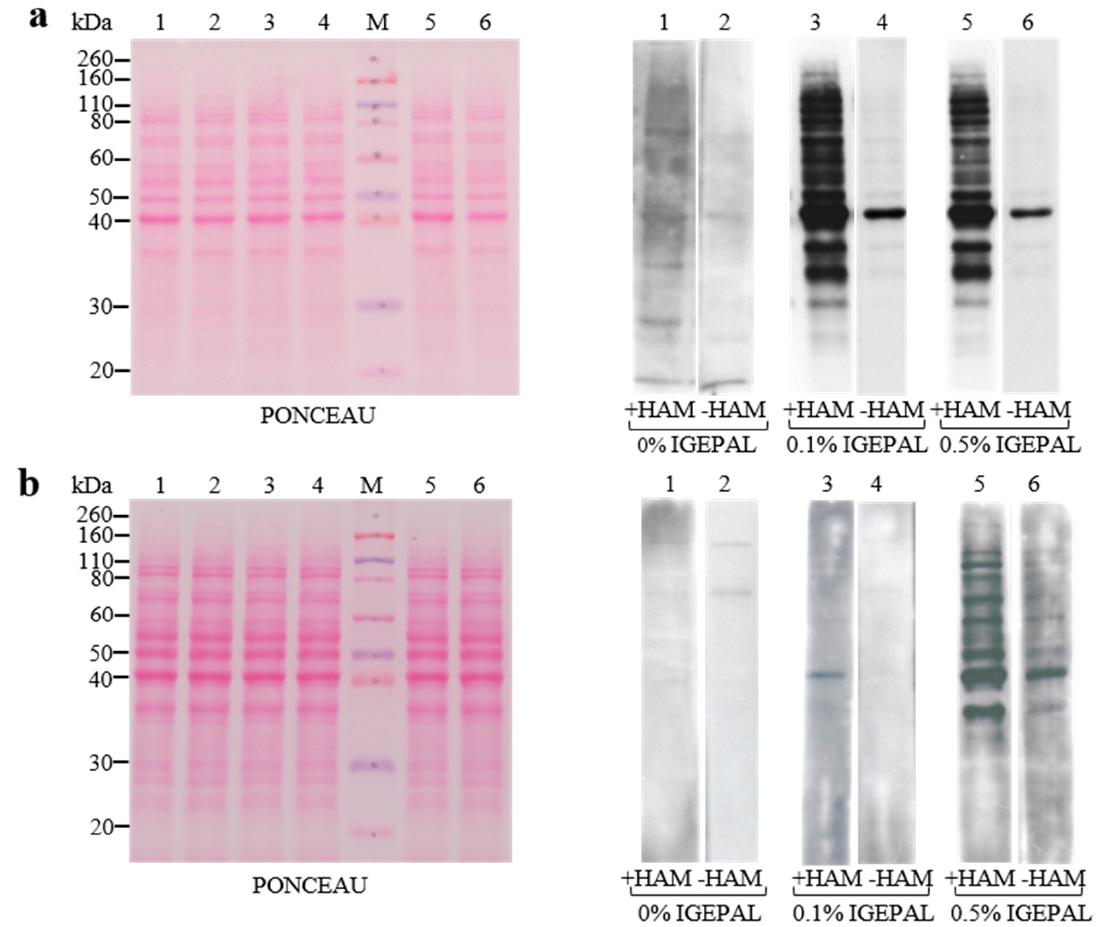
Figure 2. Comparison of ABE protocols using different membranes and IGEPAL CA-630 concentra- tions. Whole lysates from C2C12 cells (25 µ g) were electrophoresed on PAGE-SDS, transferred onto PVDF ( a ) and onto nitrocellulose ( b ), Ponceau S stained, and analyzed by the ABE procedure using different IGEPAL ® CA-630 concentrations. After the ABE protocol on the membranes, palmitoylated bands were identified using HRP-conjugated streptavidin and ECL detection. The same exposure time to Amersham Hyperfilm in ECL detection was set for the blots in ( a , b ).